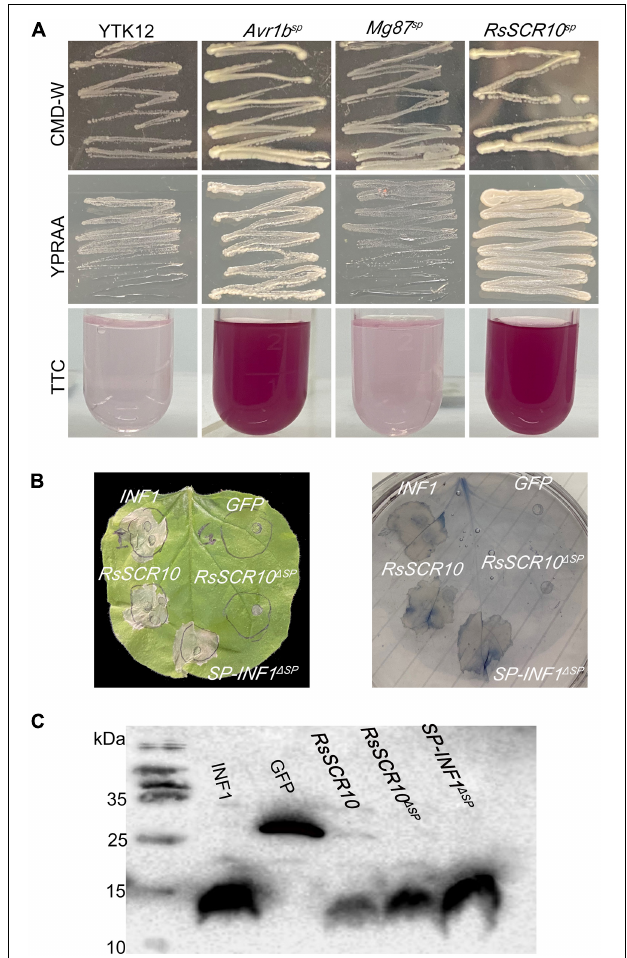
FIGURE 2 | Functional validation of SPs of RsSCR10. (A) Yeast invertase secretion assay. YTK12 and Mg87 sp , negative controls; Avr1b sp , positive control. Color conversion due to the reduction of 2,3,5-triphenyltetrazolium chloride (TTC) to insoluble red-colored 1,3,5-triphenylformazan (TPF) by invertase activity derived from yeast cells was monitored. (B) Experiments swapping the RsSCR10 with an SP of INF1. (C) Expression of proteins in infiltrated leaves was detected by western